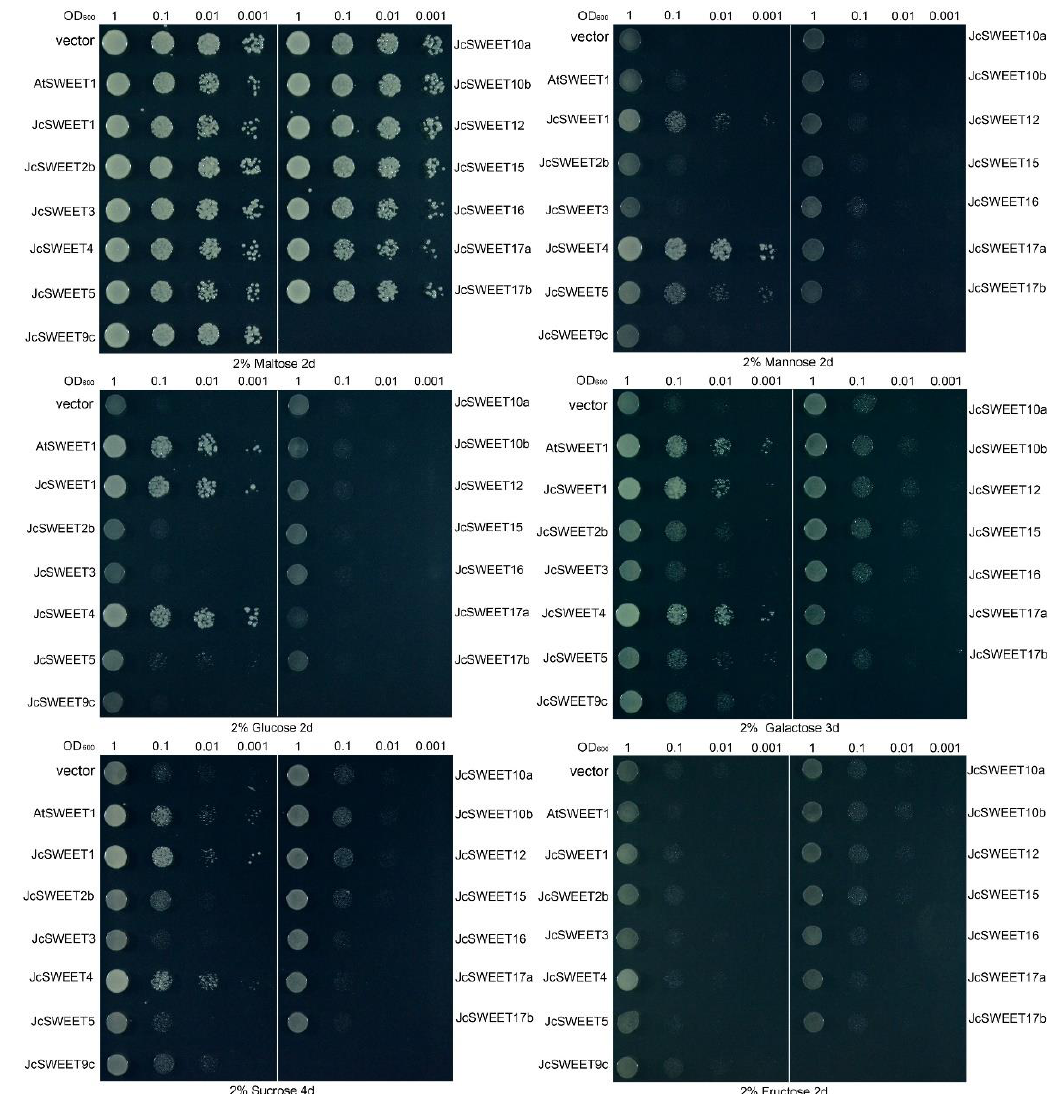
Figure 6. Complementation growth assay in the yeast EBY.VW4000 mutant. Yeast transformants expressing empty vector (negative control), AtSWEET1 and 13 JcSWEETs were grown on media containing 2% maltose, 2% mannose, 2% glucose, 2% galactose, 2% sucrose or 2% fructose. AtSWEET1 was used as positive controls for glucose, galactose and sucrose transport activities.